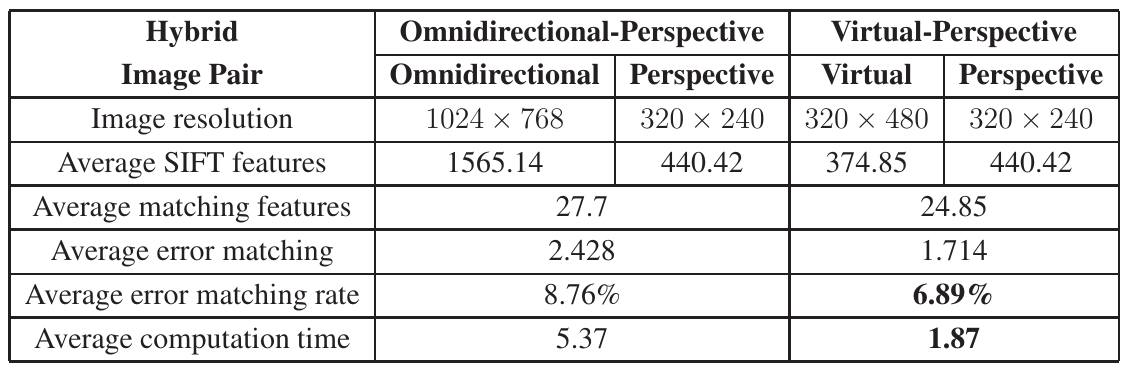
Table 3. Comparison of the SIFT feature correspondences between the direct matching of the omnidirectional-perspective and the proposed virtual-perspective image pairs. The execution time is in